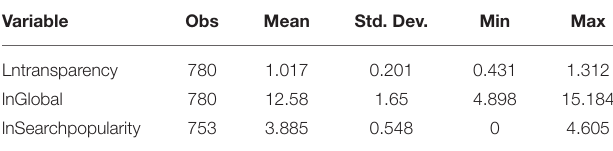
TABLE 2 | Descriptive statistics. Variable Obs Mean